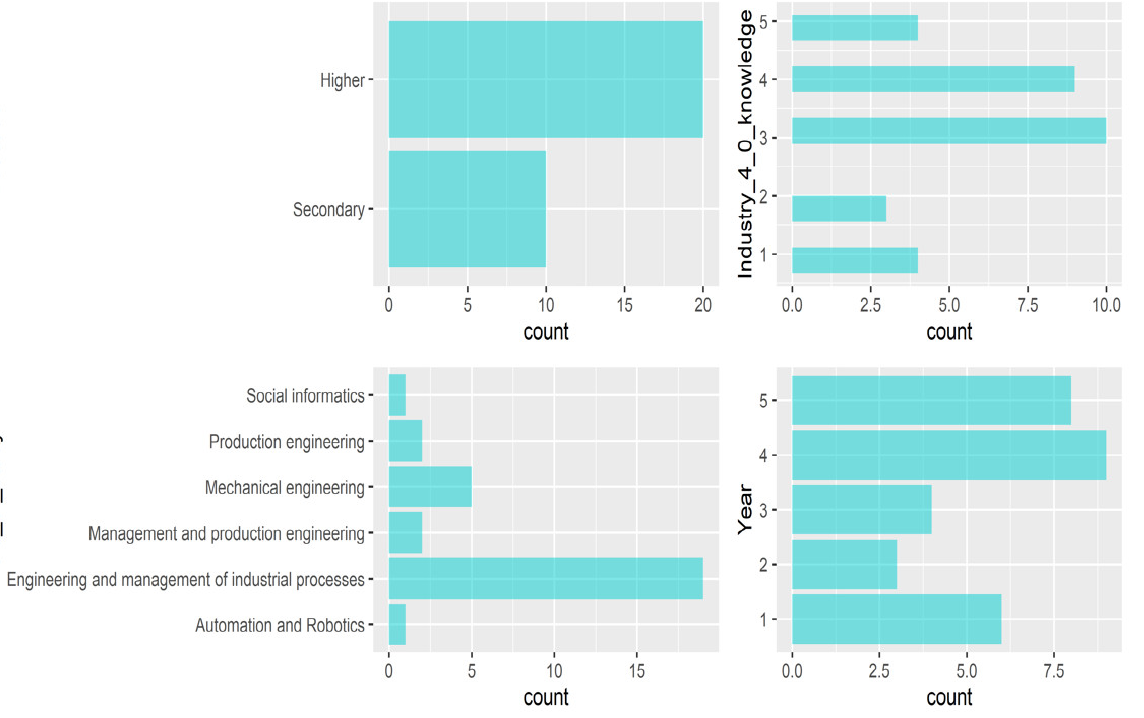
Figure 3. Assessments of digital competencies in the trials (1—not important, 5—very important). Note: student trial is marked as S, employee trial is marked as E. Source: own elaboration.